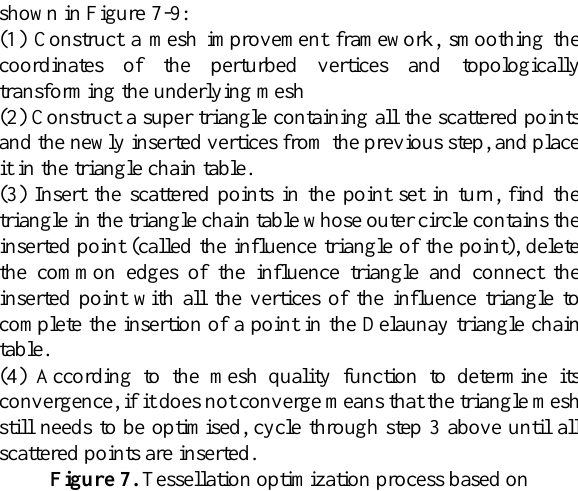
Figure 7. Tessellation optimization process based on